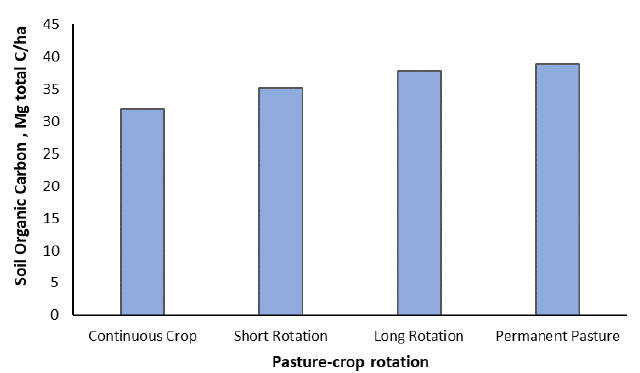
Figure 4. Crop–livestock rotation impact on soil organic carbon (SOC, 0–15 cm depth) from the ‘Palo a Pique’ long-term experiment (1995–2003). Content of SOC in continuous cropping was significantly lower than SOC in the other rotations. Adapted from Terra et al. [18].